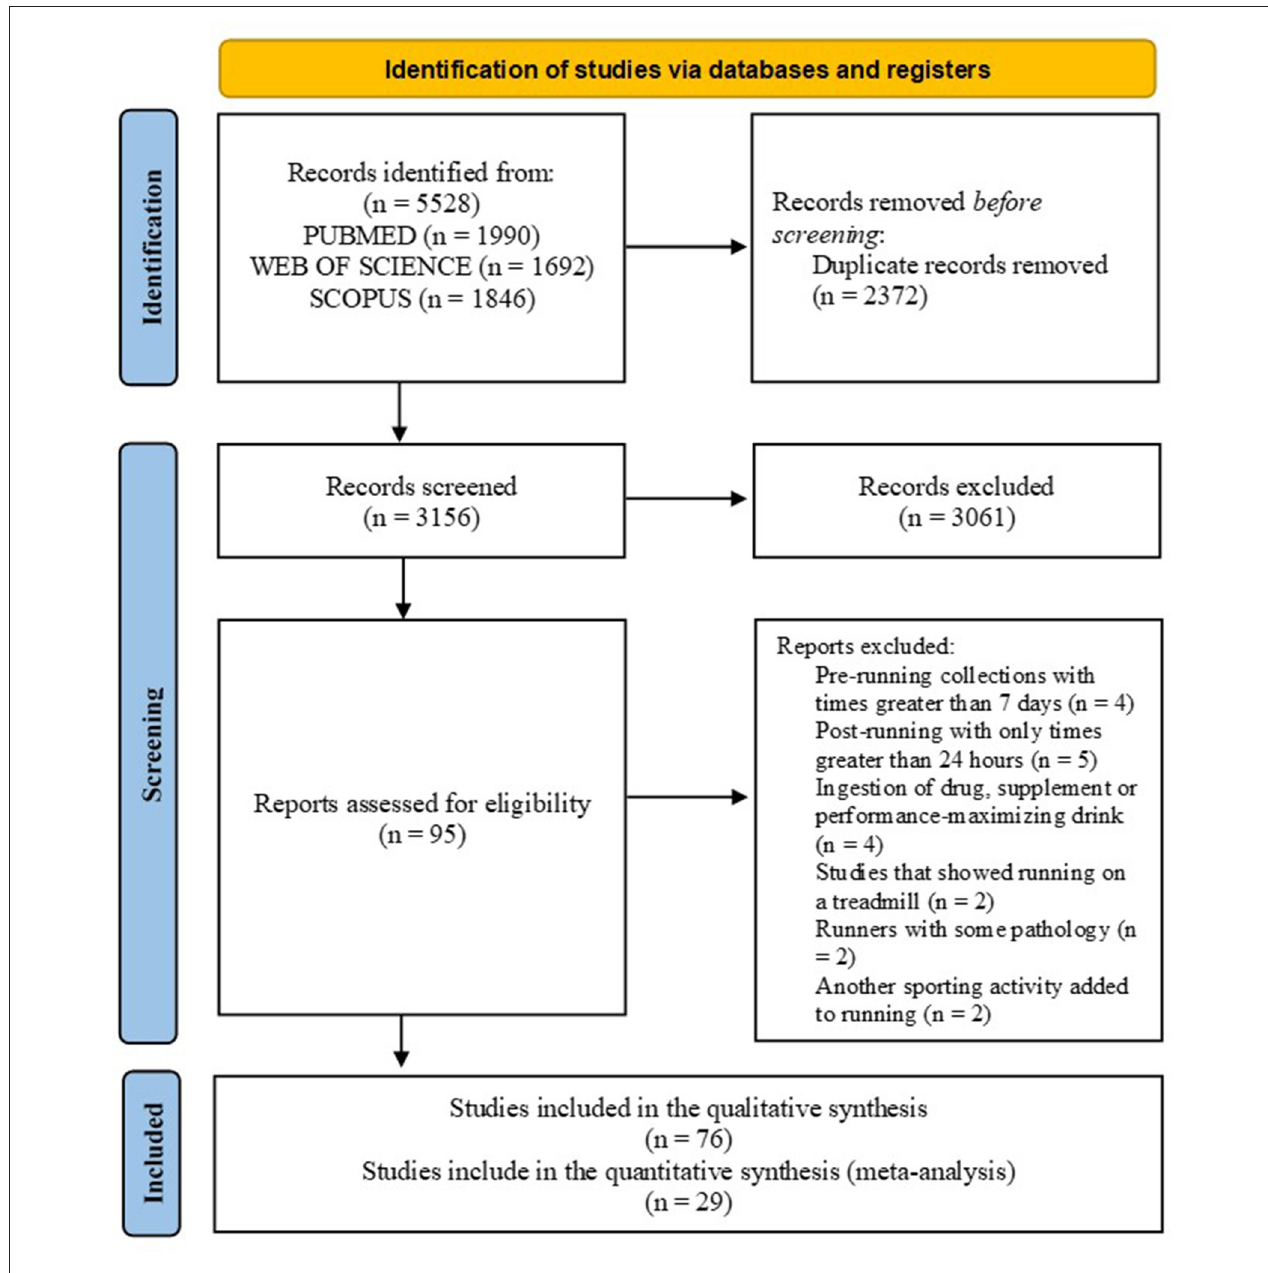
FIGURE 1 | The search flowchart for screening